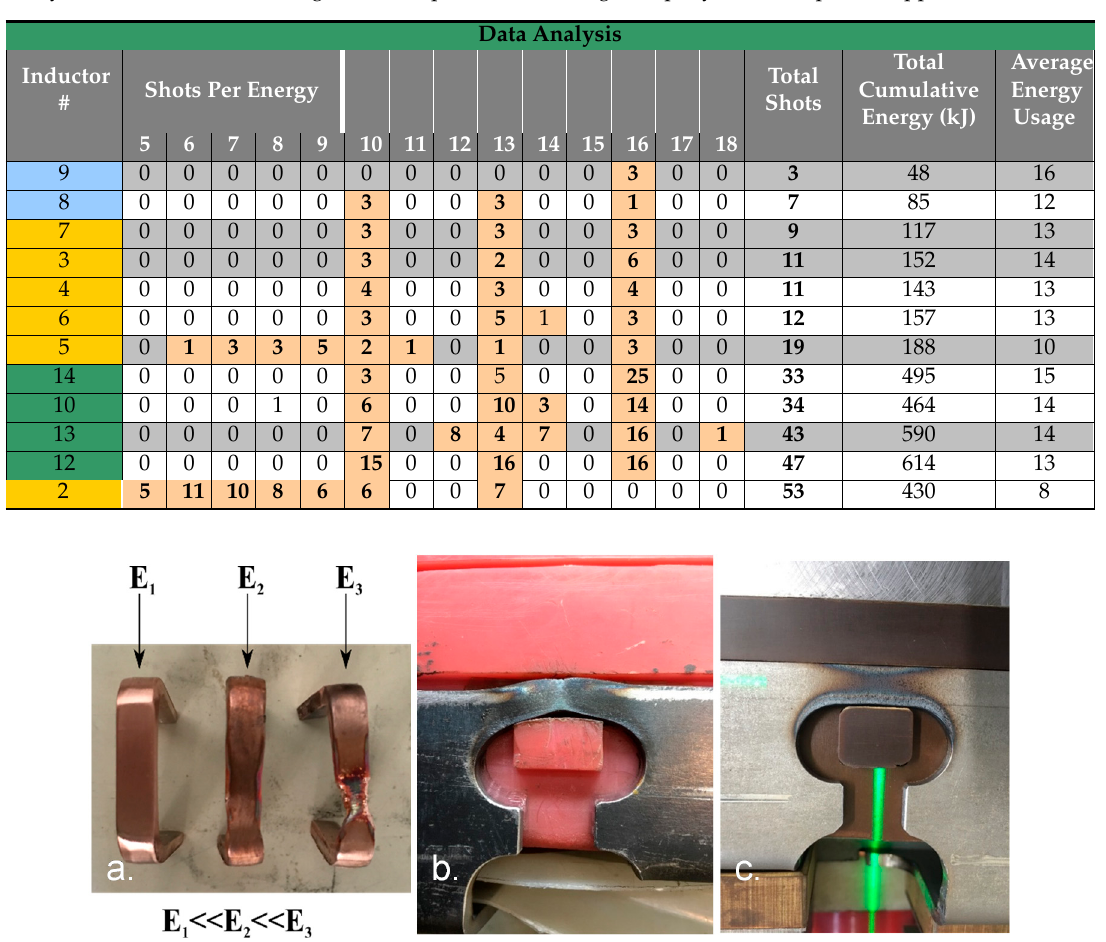
Figure 18. Effect of different levels of thermo-mechanical stresses for: ( a ) linear coil, ( b ) O-shape coil with PU support, ( c ) O-shape coil with fiberglass / epoxy resin composite support